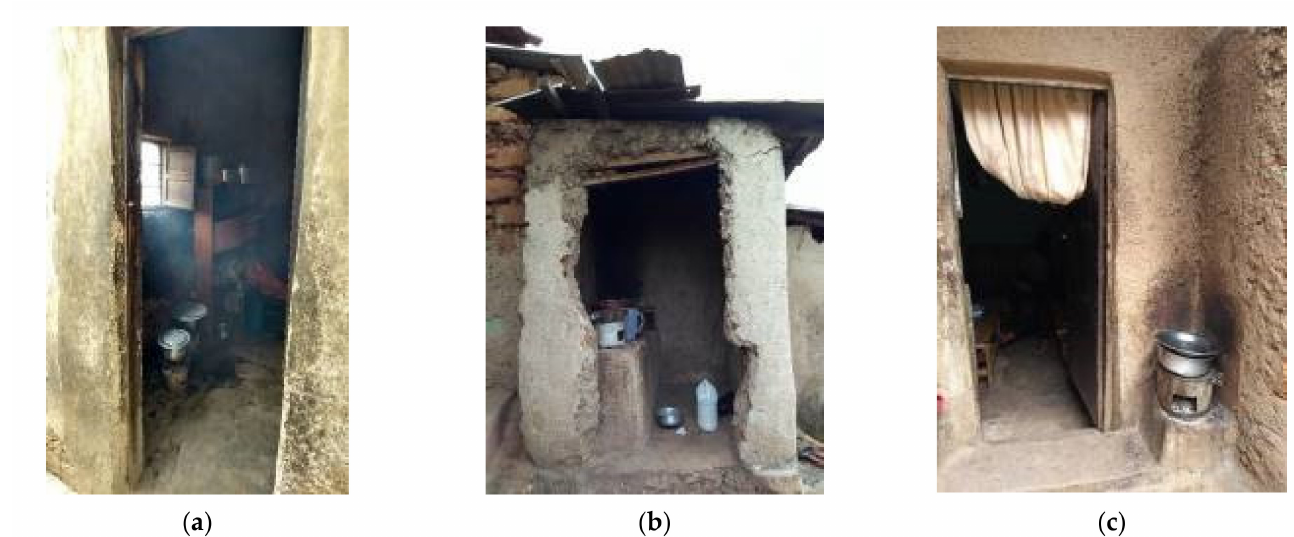
Figure 2. ( a – c ). Household cooking areas in Nyarugenge District of Kigali. Of 35 women who provided information about cooking times, just over half (51%) cooked one meal per day, most commonly in the morning between 10 a.m. and 12 noon. These women commented that they cooked a large quantity of food at once so that there was enough to eat later in the day. Women cooking two (37%) or three (11%) meals per day also frequently reported cooking between 10 a.m. and 12 noon and 6 p.m. and 8 p.m. The total time women spent attending their cookstove each day ranged from a minimum of 1 h to a maximum of 8 h (median = 3 h), meaning that some women were spending up to one third of every 24 h period near their stove (within 2 m). Women who cooked more meals each day spent longer on average near their stoves, as did their children (Figure 3), with the accompanying exposure to cooking smoke. Women cooking one meal per day spent on average (median) 2 h near their stove whilst women cooking three meals per day spent 5 h on average. For each ‘meal group’, the time the child spent near the stove was less than the